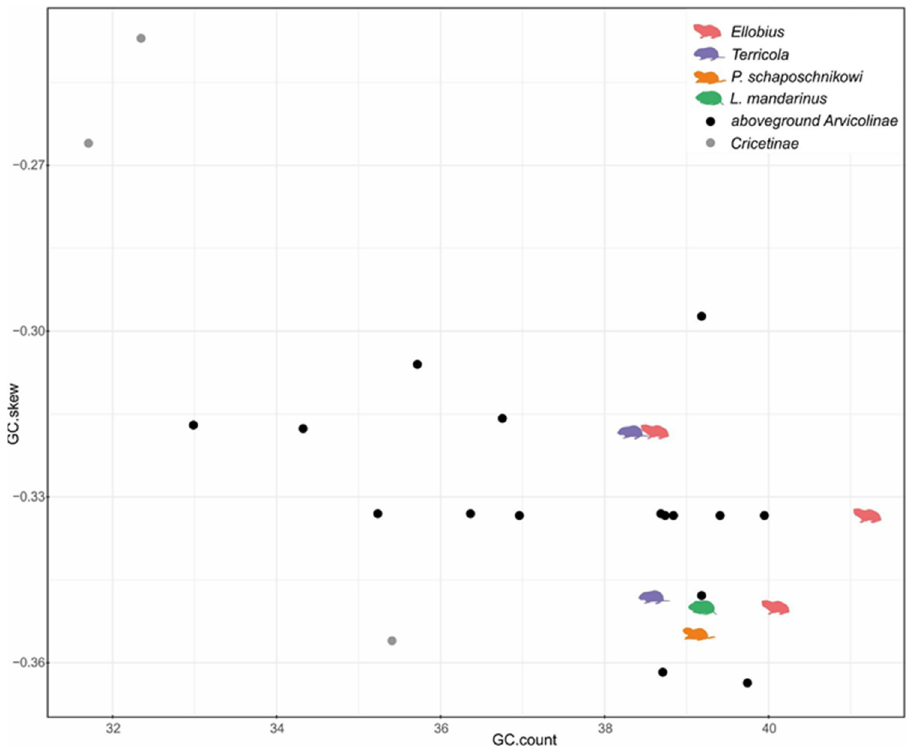
Figure 2. Variation of GC-content and GC-skew values in mitochondrial genomes of Arvicoli- nae. Black dots—aboveground vole species (Arvicolinae), grey dots—hamsters (Cricetinae), color symbols—subterranean vole